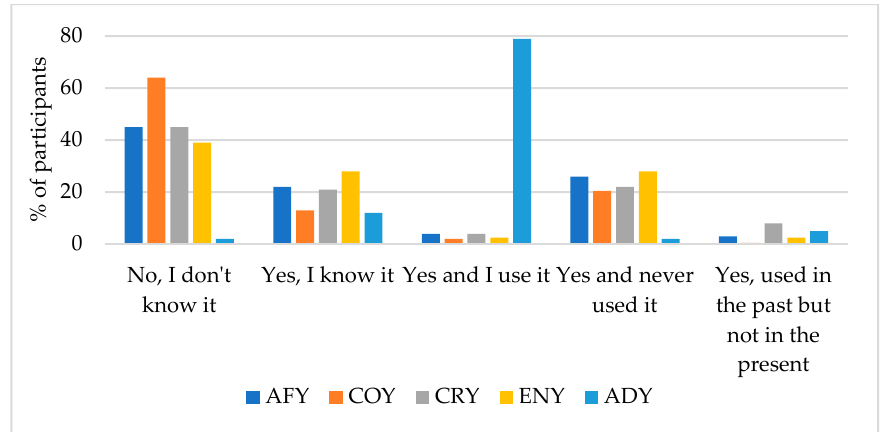
Figure 1. Knowledge and use of yeast formulations available for the winemaking and admitted by the International Organization of Vine and Wine. Legend: ADY, active dried yeast; AFY, active frozen yeast; COY, compressed yeast; CRY, cream yeast; ENY, encapsulated yeast.